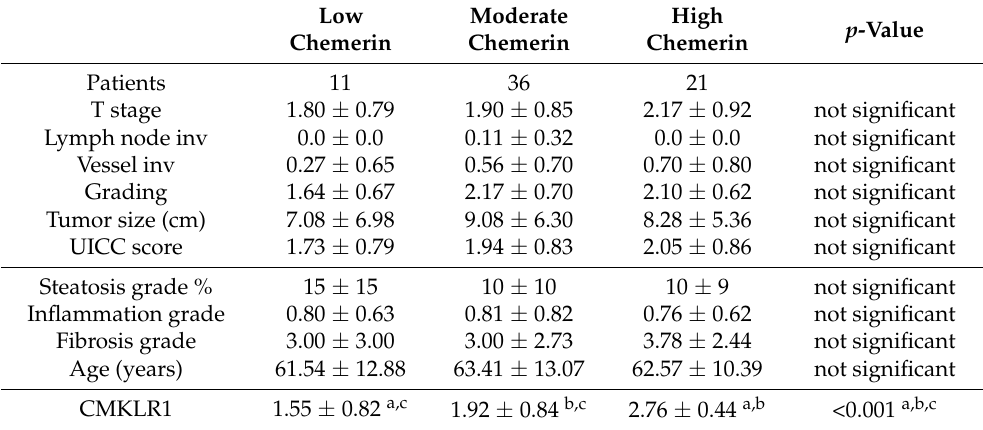
Table 2. T stage, lymph node invasion, vessel invasion, grading, UICC stage, steatosis, inflammation, fibrosis stages, age, and CMKLR1 scores of female patients stratified for low, moderate, and high chemerin protein levels in the tumors. a: comparison of tumors with low and high chemerin, b: comparison of tumors with moderate and high chemerin, and c: comparison of tumors with low and moderate chemerin (inv, invasion).